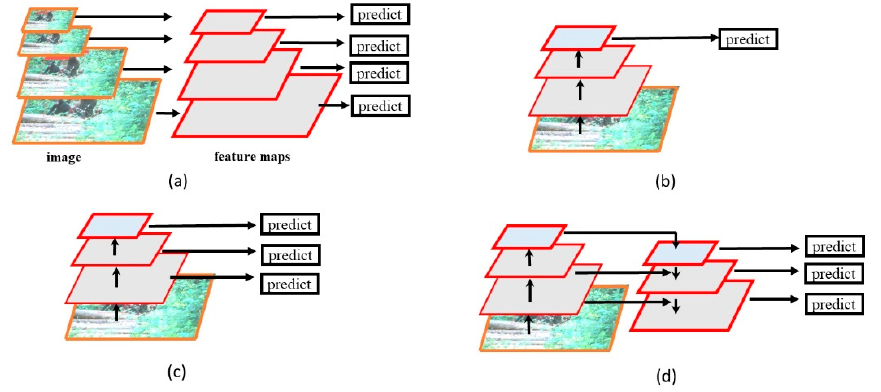
Figure 6. ( a ) Featurized image pyramid. ( b ) Single feature map. ( c ) Pyramidal feature hierarchy. ( d ) Feature Pyramid Network.